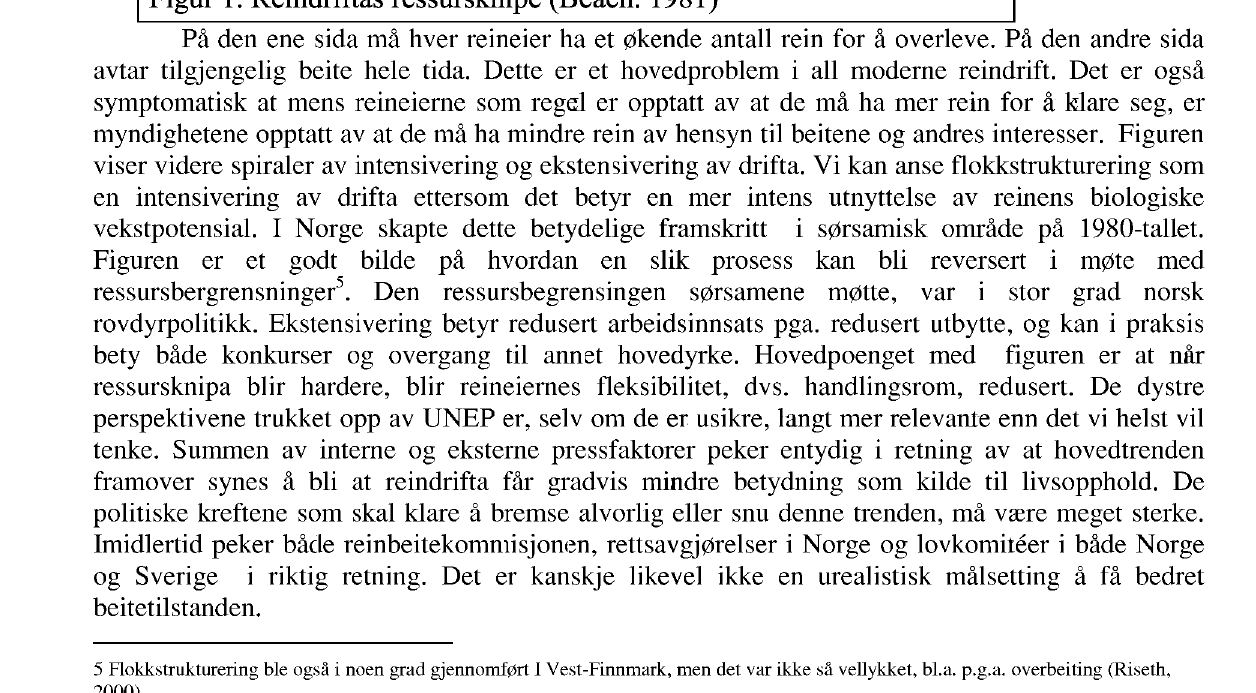
Figur 1. Reindriftas ressursknipe (Beach.